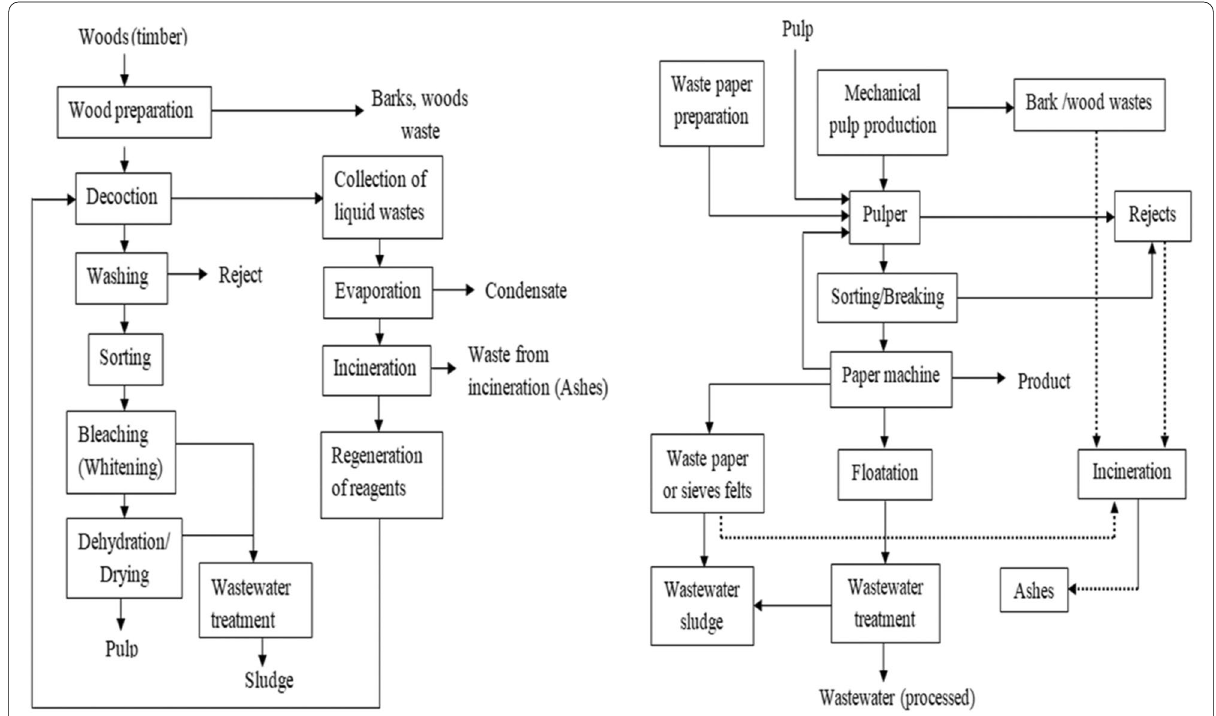
Fig. 4 Sites of waste generation in pulp and paper